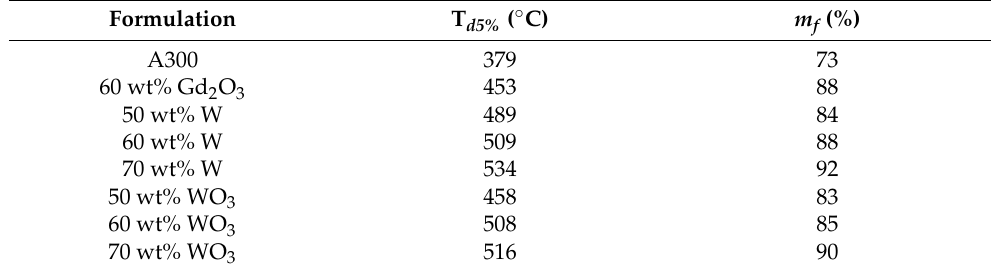
Figure 17. TGA curves for representative samples of each 3D printed formulation. Table 6. Thermal stability properties of a representative sample of each 3D printed formulation.